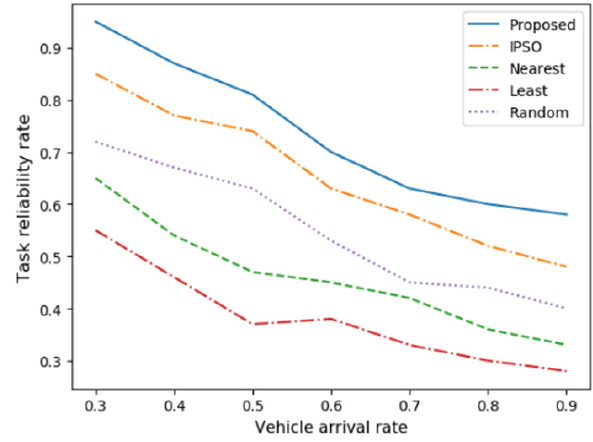
Figure 13. Task reliability rates for vehicle arrival rate.